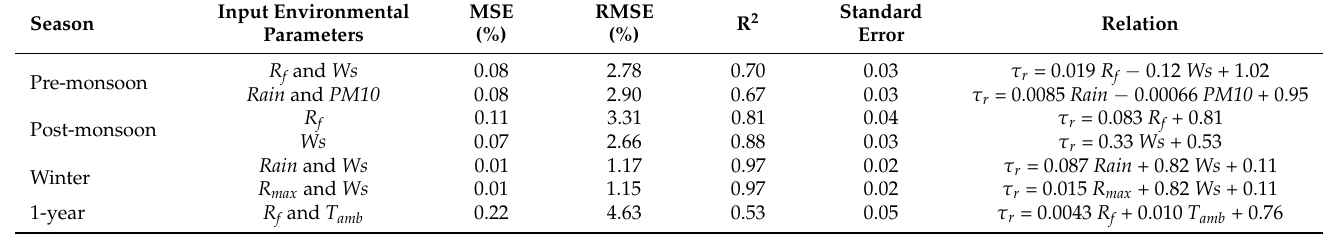
Table 3. The seasonal analysis result of the MLR model in correlating the average relative direct transmittance of the weekly cleaned glass (G2) and the environmental parameters with a p -value < 0.05 along with the statistical errors mean square error (MSE) and root mean square error (RMSE) between the predicted and measured average relative direct transmittance.